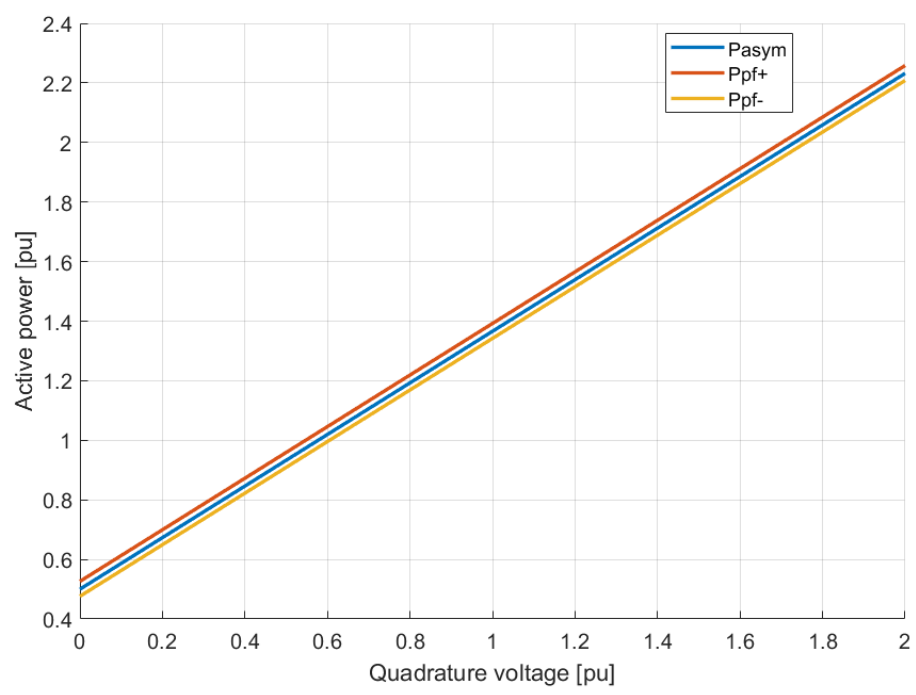
Figure 7. ACPST active power curves for 105% U n (red), U n (blue), and 95% U n (yellow). Table 1. ACPST energy parameters for constant input voltage and output voltage.